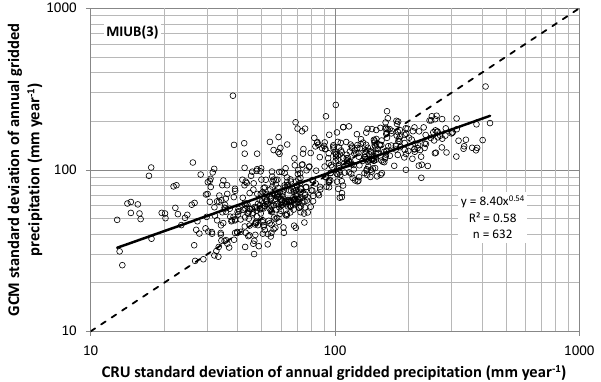
Figure 4. Comparison of MIUB(3) model estimates of the standard deviation of annual precipitation with CRU observed estimates. (Based on untransformed precipitation NSE = 0.515, rank 4 of 46 runs, and R 2 = 0.524.)